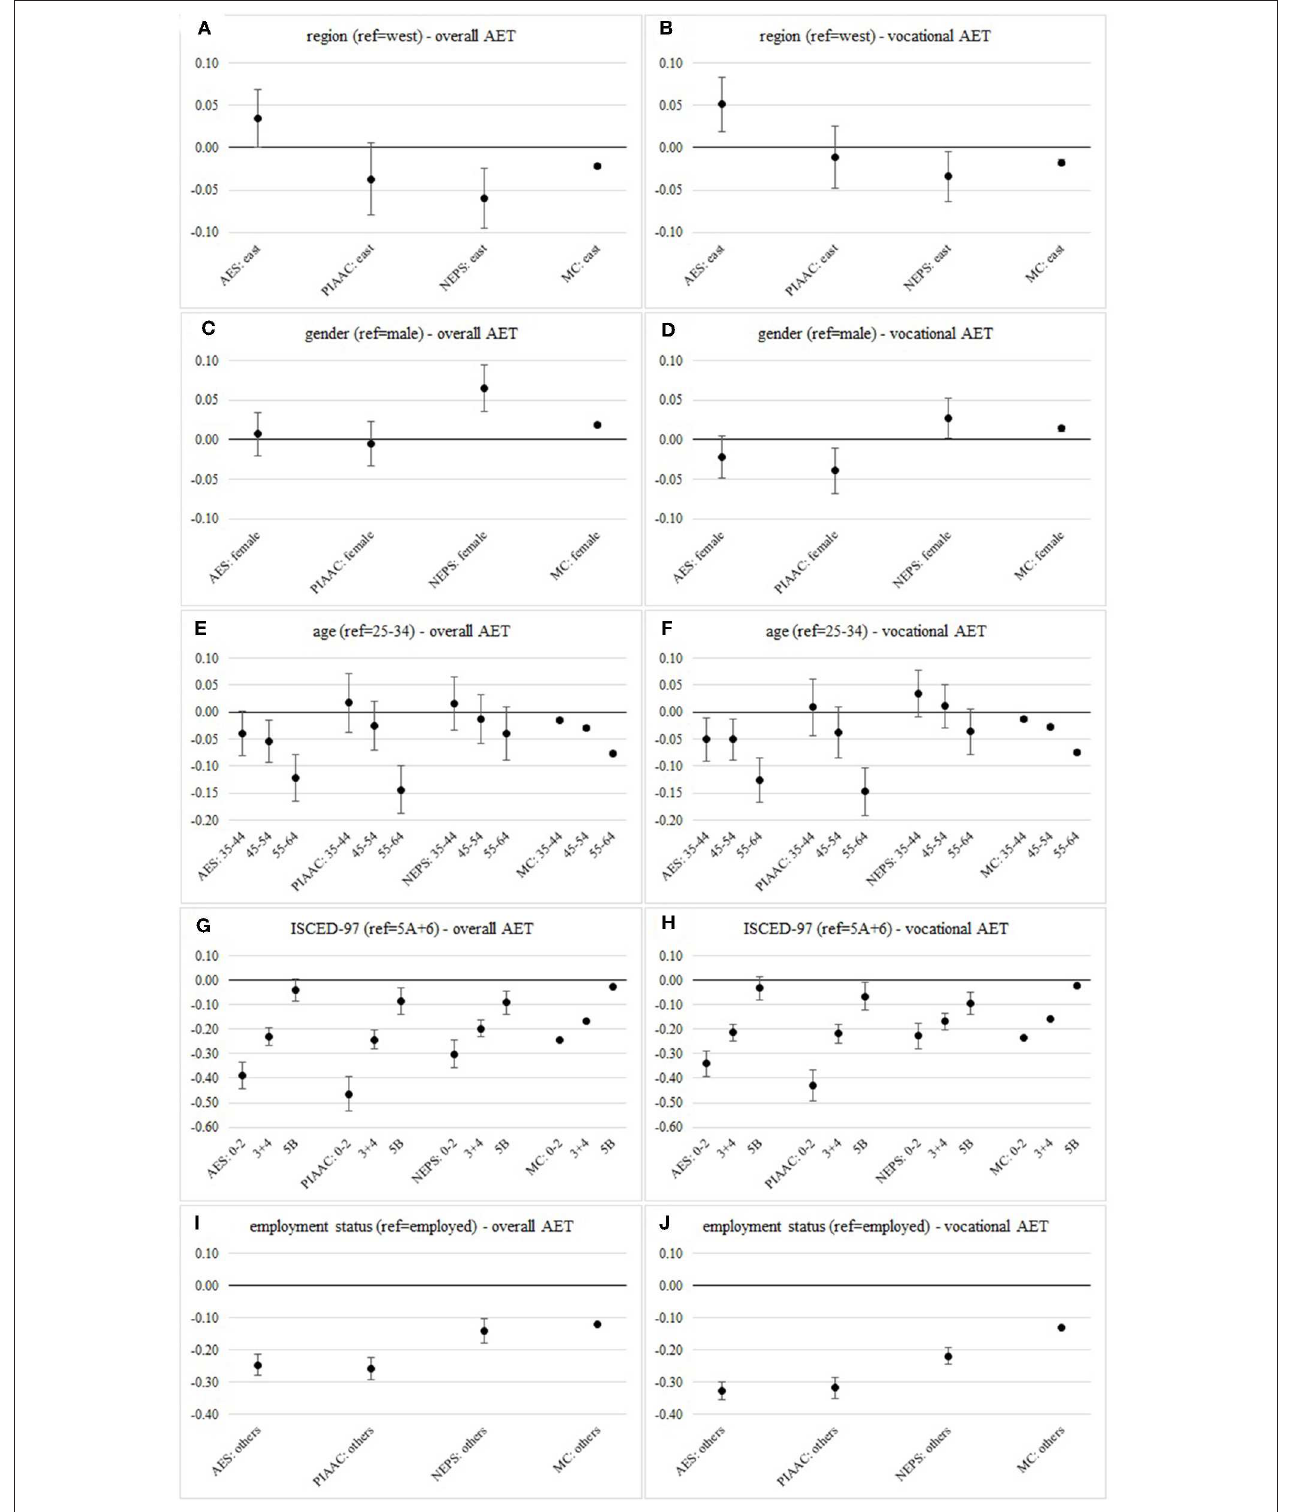
FIGURE 2 | Average marginal effects on the probability to participate in AET in Adult Education Survey (AES), Programme for the International Assessment of Adult Competencies (PIAAC), National Educational Panel Study (NEPS) and Microcensus (MC) of (A) region on overall AET, (B) region on vocational AET, (C) gender on overall AET, (D) gender on vocational AET, (E) age on overall AET, (F) age on vocational AET, (G) ISCED-07 on overall AET, (H) ISCED-07 on vocational AET, (I) employment status on overall AET, and (J) employment status on vocational AET. Data sources: AES 2012, PIAAC 2012, NEPS SC 6 wave 5, Microcensus 2012 (weighted, own